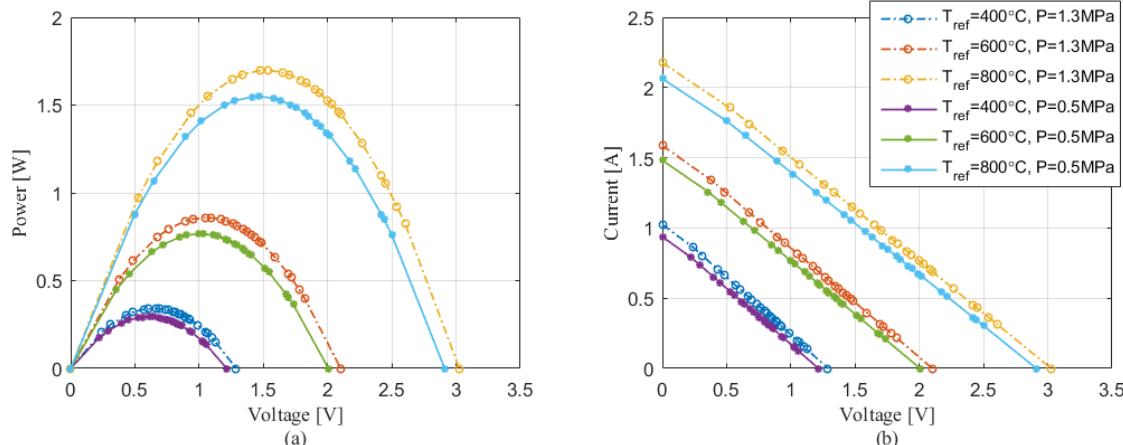
Figure 5. I ‐ V and P ‐ V characteristics for CMO ‐ 25 ‐ 42S. The module was tested at heater temperatures Figure 5. I-V and P-V characteristics for CMO-25-42S. The module was tested at heater temperatures T ref = 400 °C, 600 °C, and 800 °C, at two different pressure values, 0.5 MPa (solid line) and 1.3 MPa T ref = 400 ˝ C, 600 ˝ C, and 800 ˝ C, at two different pressure values, 0.5 MPa (solid line) and 1.3 MPa (dash ‐ dot line). (dash-dot Table 1. Parameter characterization ( V OC —open ‐ circuit voltage, I SC —short ‐ circuit current, R TEG —TEG resistance, T h —temperature at TEG hot surface, T c —temperature at TEG hot surface) at different temperature references for the heater (400 °C, 500 °C, 600 °C, 700 °C and 800 °C), each for the two pressure values (0.5 MPa and 1.3 MPa).